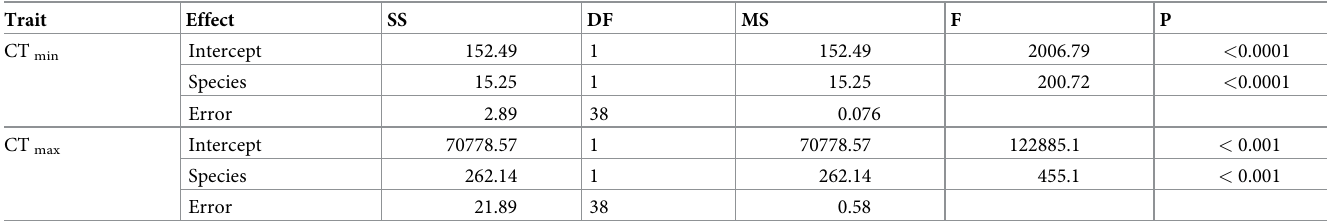
Table 2. Summary statistical results from full factorial ANOVA showing effects of species on critical thermal limits (CT max and CT min ).